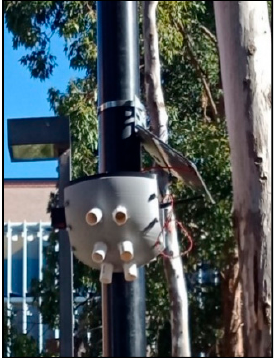
Figure 8. Proposed system installed on the electric pole.